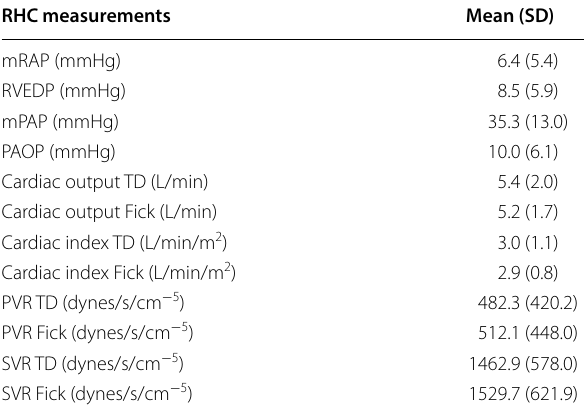
Table 3 Right heart catheterization measurements